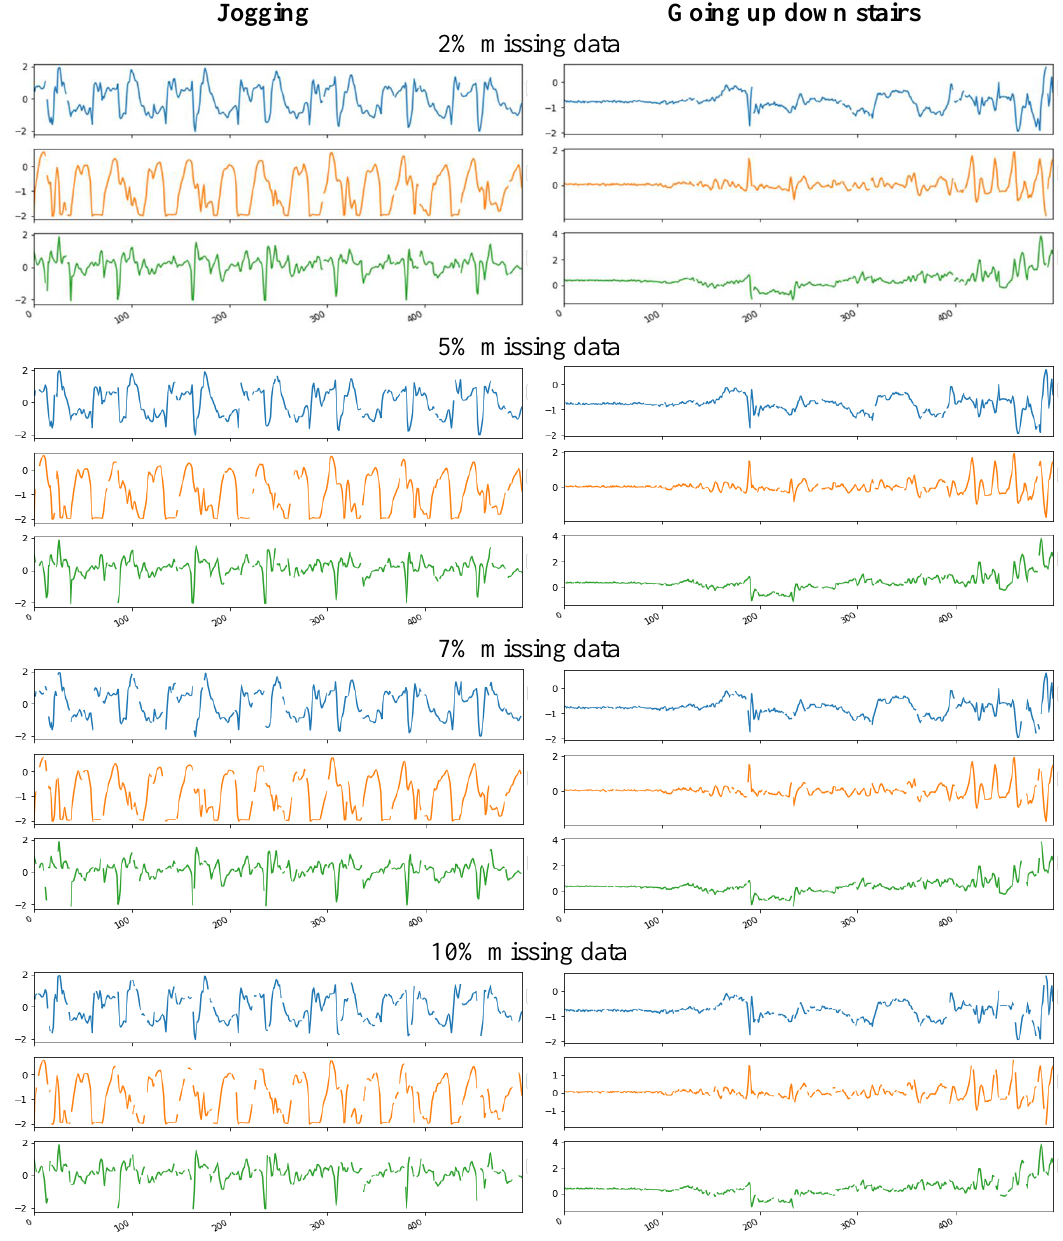
Figure 4. Data sequence of ’jogging’ and ’going up down stairs’ from two benchmark datasets that have different percentages of missing data. Missing rates are from 2% to 10%. Accelerometer data for x -, y -, and z -axes are shown for each